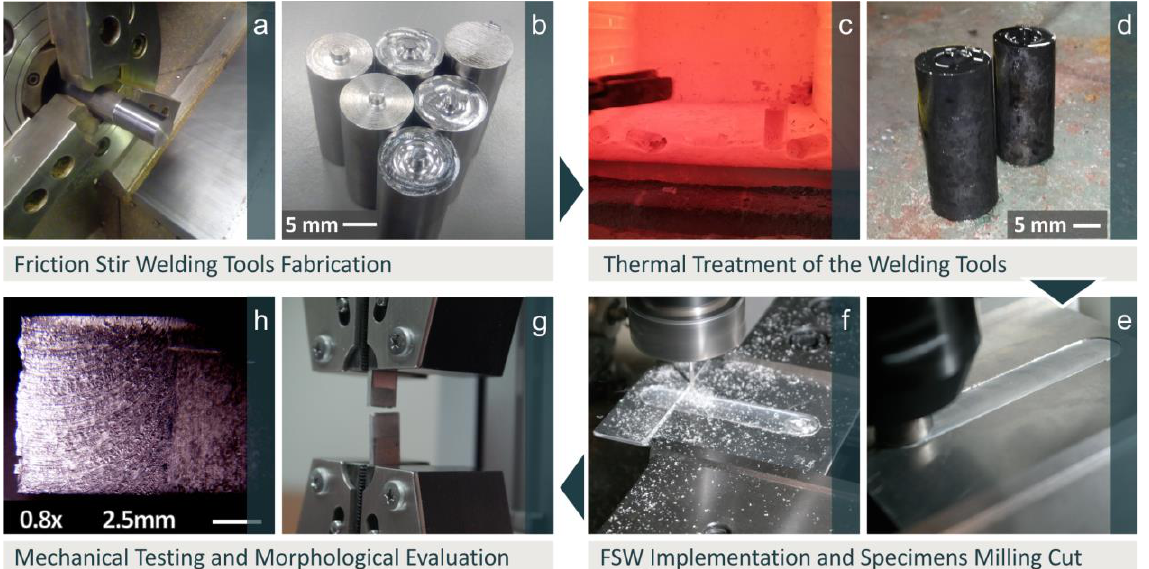
Figure 1. Procedure followed: ( a , b ) weld tool fabrication, ( c , d ) heat treatment of tools, ( e , f ) welding, ( g , h ) mechanical testing and morphological evaluation of welds.